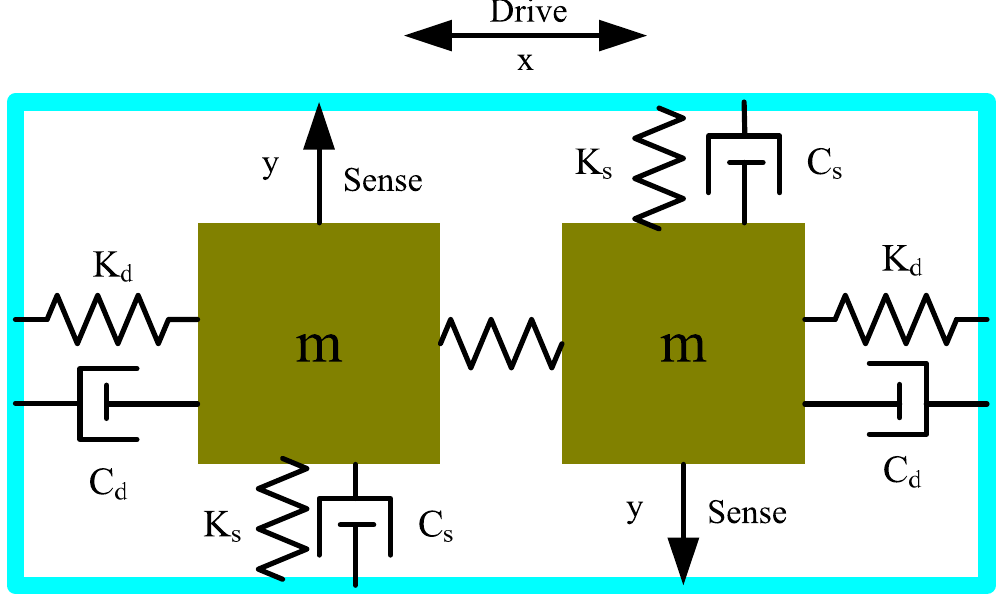
Figure 4. Dual mass gyroscope modelled as spring-mass-damper